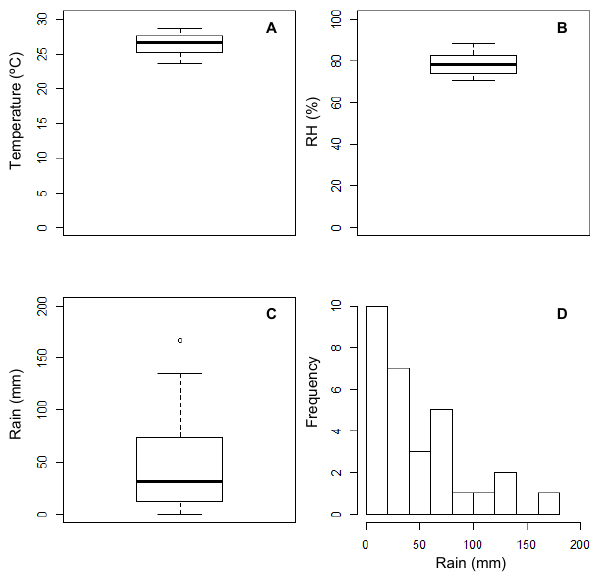
Figure 1. Boxplots of the distributions of temperature (T, ºC) (A), relative humidity (RH, %) (B), accumulated rain- fall (in mm) (C), and frequency distribution of accumulated rainfall (in mm) (D), registered during 30 2-week periods in which the dispersal of Diplodia , Lasiodiplodia , and Neofusicoc- cum conidia was studied in four Brazilian vineyards. Boxes include the 2nd and 3rd quartiles of the data, the dotted line is the median, whiskers extend to minimum and maximum values, and points are